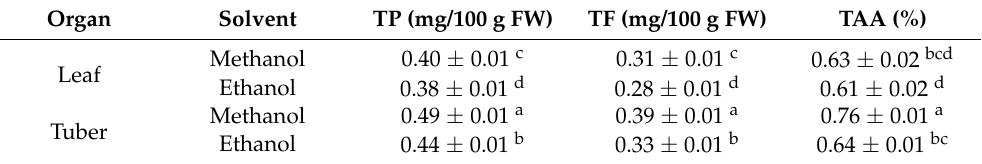
Table 4. The content of total phenolics (TP), total flavonoids (TF), and total antioxidant activity (TAA) in endangered terrestrial orchid species H. affine (Boiss.) Schltr. as affected by organ and solvent type. Organ Solvent TP (mg/100 g FW) Leaf